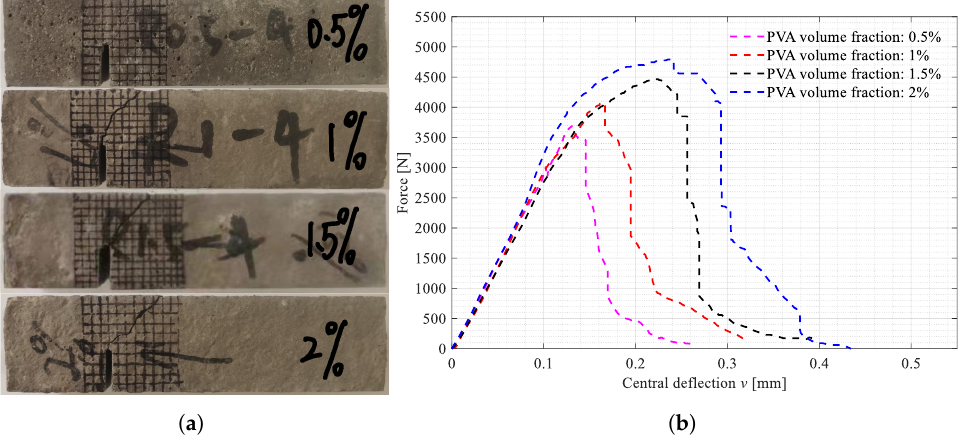
Figure 9. The broken beam specimens with C l = 40 mm and the central deflection-force diagrams.